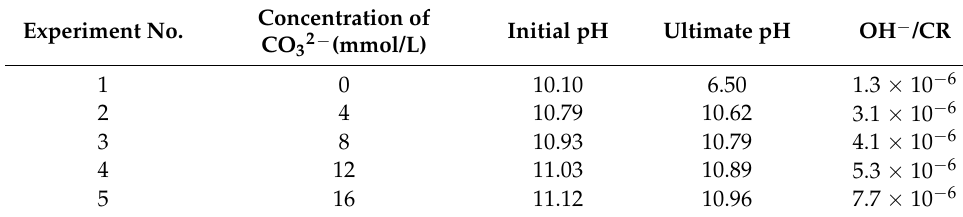
Table 2. Experimental scheme of CO 32 − interference in the digestion of ammonium chloride. Experiment